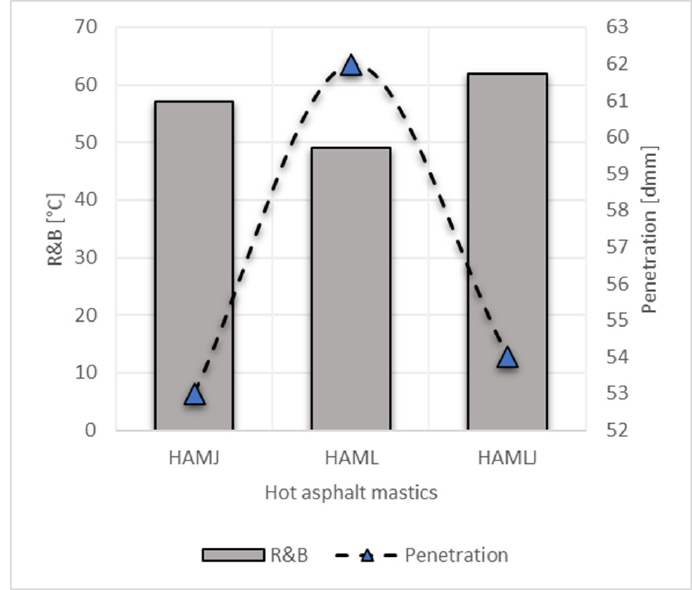
Figure 8. R&B and penetration value of the hot asphalt solutions. Looking at the comparison of the cold asphalt solutions with the hot ones that have the same filler type and content, all the cold asphalt mastics returned on average 8% lower R&B values than the hot mastics after the accelerated curing time, although they had 11.5% higher R&B values than that of B5070. On the contrary, after the 28 days of long curing time, CAML and CAMJ achieved the same R&B values of HAML and HAMJ, respectively, while CAMLJ had 19% higher R&B value than that of HAMLJ. The penetration values of the hot asphalt mastics (see Figure 8) are compliant with the R&B values of the same mastics: the highest R&B value corresponds to the